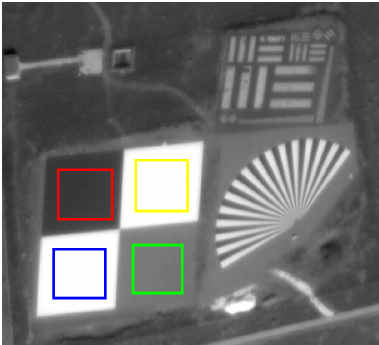
Figure 7. MTF estimated on the reconstruction of the synthetic slanted-edge target ( × 2 ) using different methods (shown in Figure 6). The proposed method (ACT-spline) has a higher MTF than the other methods, which means that the method was able Figure 5. Synthetic example of super-resolution on the EIA to recover more information in high frequencies. Target (zoom × 2 ). The figures correspond to the methods described in the text.